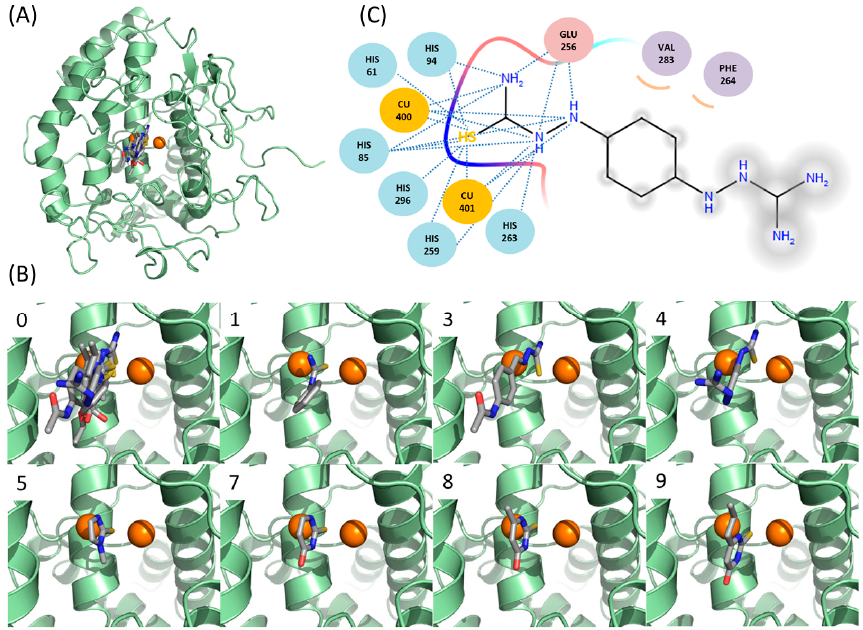
Figure 4. Predicted binding modes of the thiourea-containing compounds. ( A ) Overlaid inhibitors against mushroom tyrosinase. Chain A of mushroom tyrosinase [15] (PDB: 2Y9X) are used for the docking with DOCK 3.6 [42]. The sphere and grids of the protein were prepared assuming the met-state of the copper atoms with the protocol by DOCK blaster [43]. The two copper atoms in tyrosinase are drawn as orange circles; ( B ) predicted binding mode in each inhibitory compound. (0) Overlay of the inhibitors in this study, (1) phenylthiourea, (3) thioacetazone, (4) ambazone, (5) methimazole, (7) thiourasil, (8) methylthiourasil, and (9) propylthiourasil. The yellow, red, and blue colors indicate the sulfur, oxygen, and nitrogen atoms, respectively. All the figures are prepared by Pymol [44] and arranged in the same orientation; and ( C ) schematic diagram of the representative interaction between ambazone and tyrosinase. Residues in tyrosinase are drawn in circles. Residues for hydrophilic and hydrophobic interactions are coloured in pink and purple, respectively. Dashed lines correspond to hydrophilic interactions. Curves indicate hydrophobic contacts. Atoms exposed to solvent exposure are shaded.